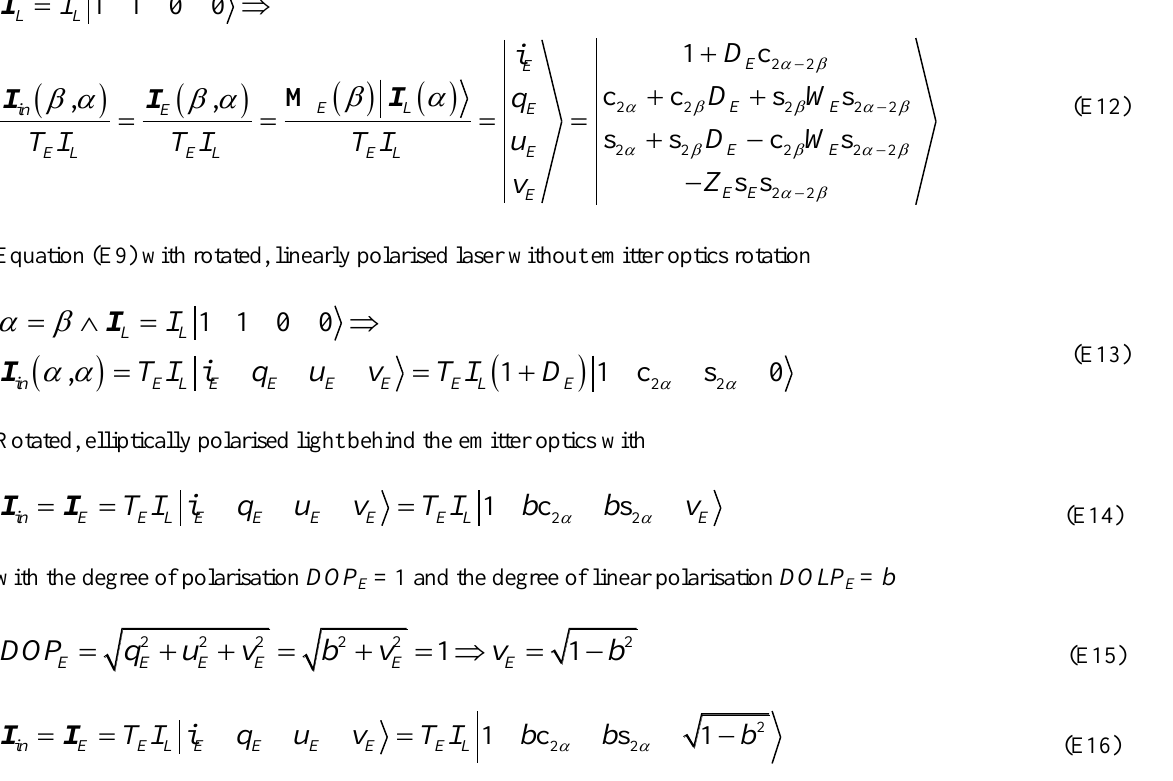
Rotated, linearly polarised laser with linear polarisation parameter a (E7) and rotated diattenuator Eq.